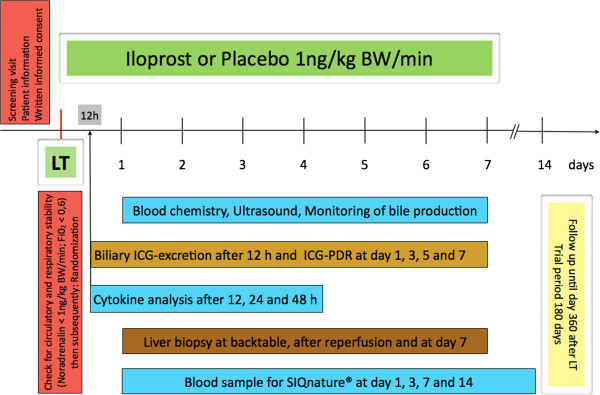
Treatment schedule.